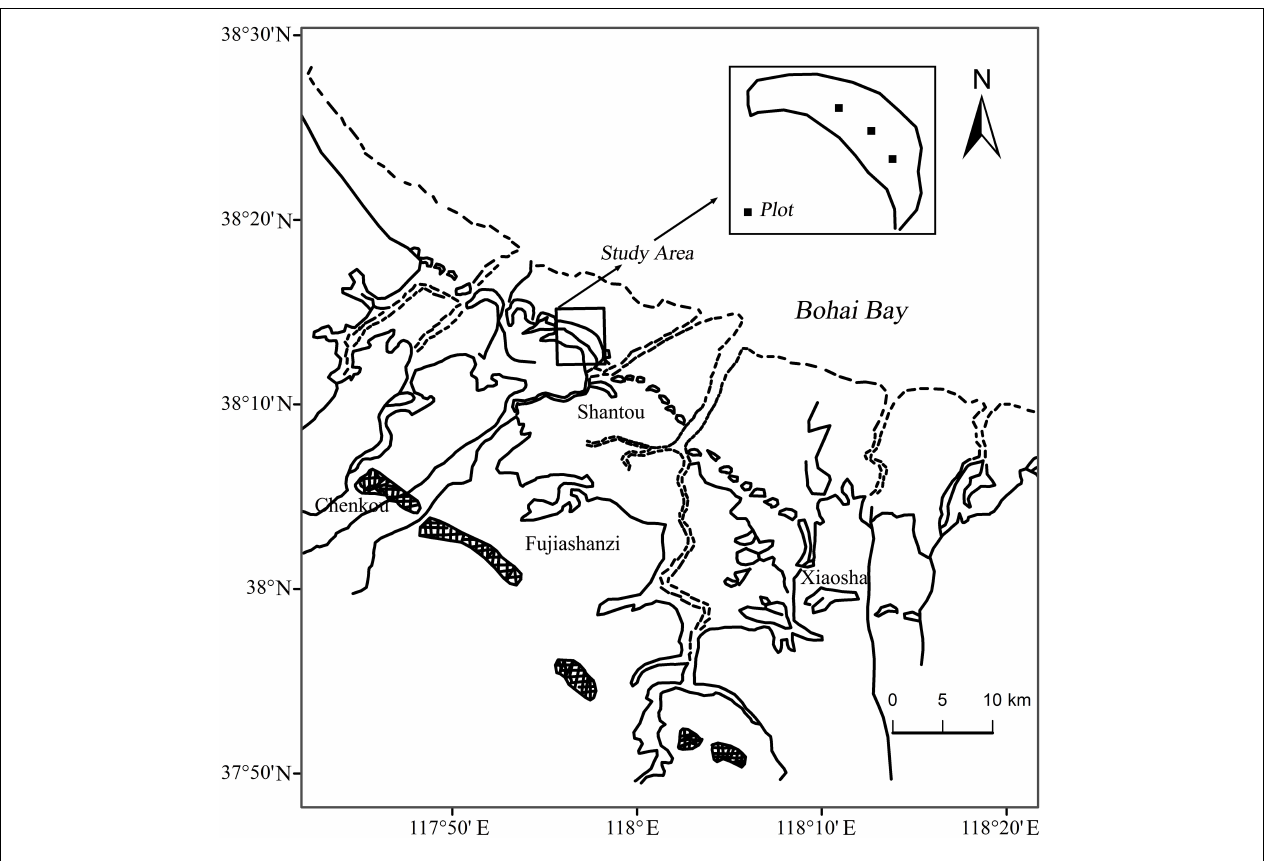
FIGURE 1 | Location map of the study area and sampling